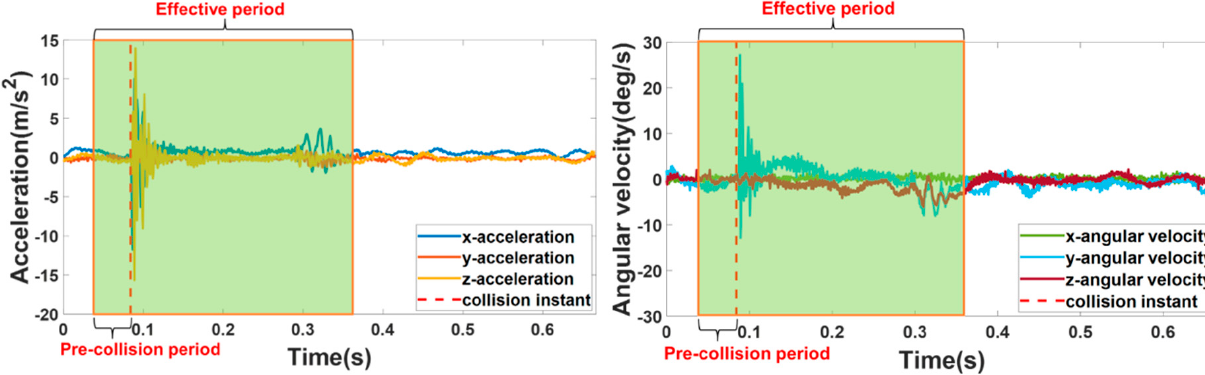
Figure 2. The waveform of a collision point.